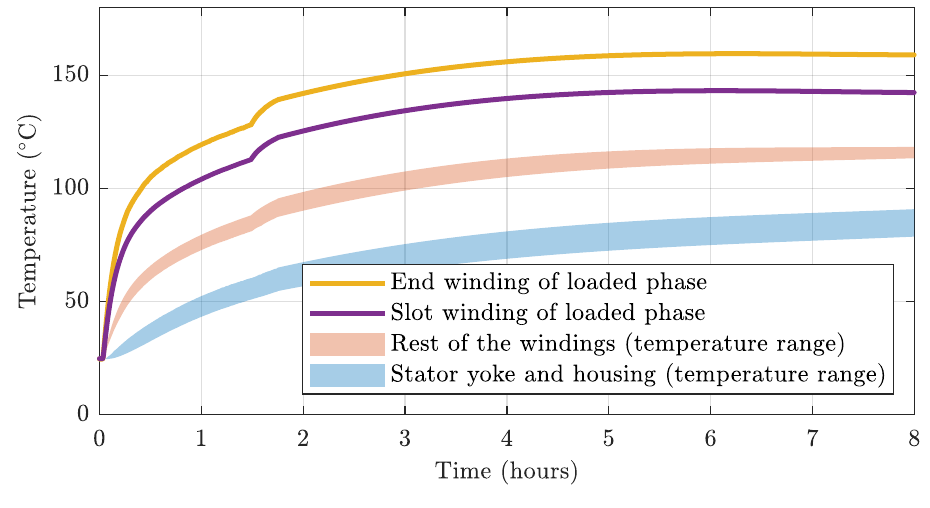
Figure 18. Temperature